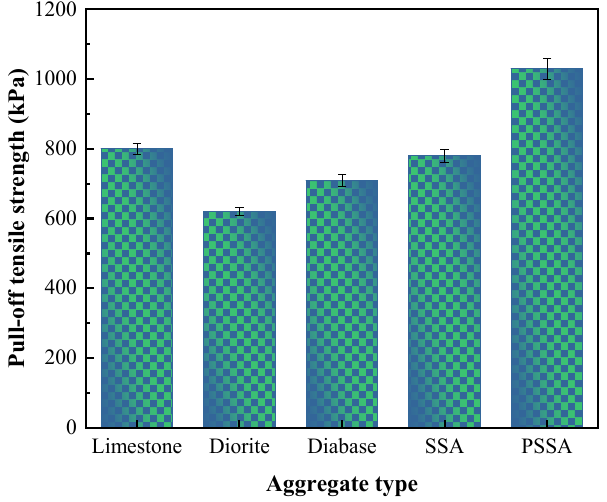
Figure 12. BBS test results.